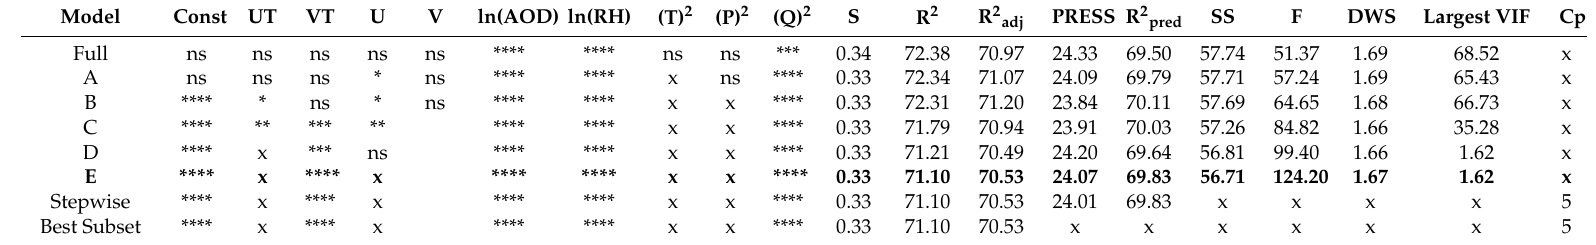
Table 3. Multiple linear regression models for predicting (VR) 2 . The final model selected for estimating (VR) 2 is highlighted.